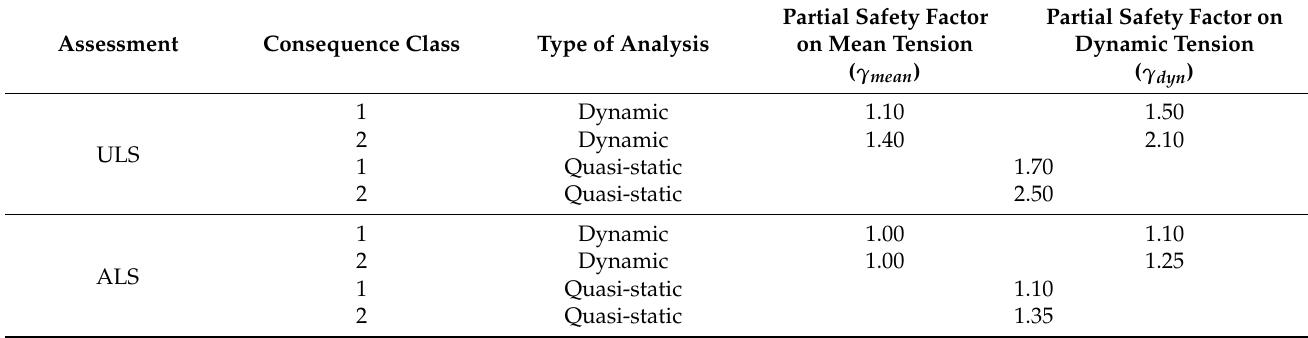
Table 12. DNV’s partial safety factor for ULS and ALS assessment of mooring system.